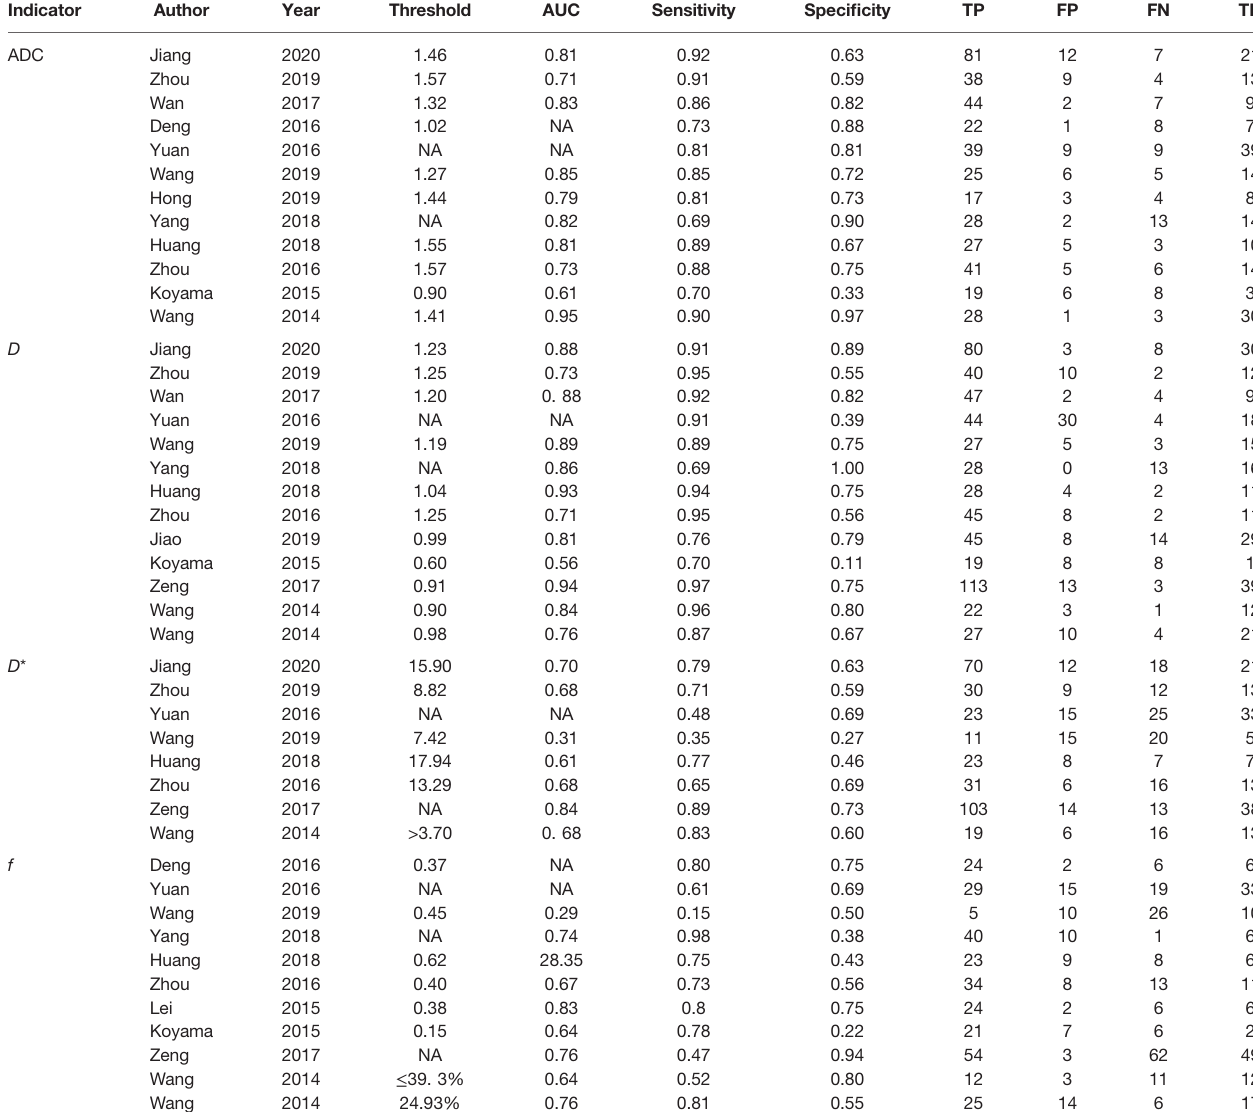
TABLE 2 | Diagnostic performance for each study.